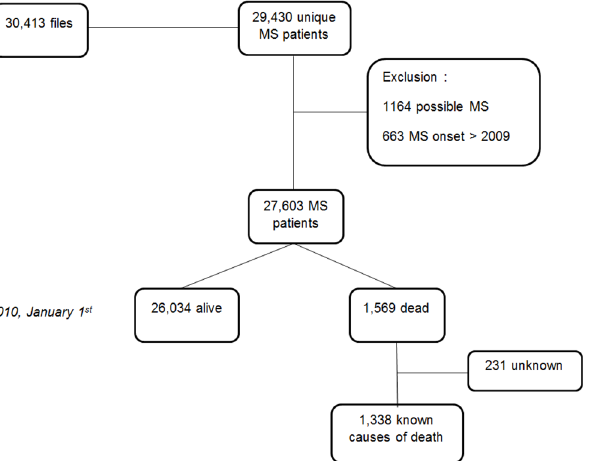
Fig 1. Flowchart of the study population. These patients had the classic characteristics of MS populations: F/M sex ratio 2.47 (19,656/7,947); mean age at MS clinical onset 32.8 ± 10.6 years; and 85.5% relapsing- onset MS (23,438/27,408; 195 missing values). As expected, mean age at onset was significantly higher and F/M sex ratio lower for progressive onset MS than for relapsing-onset MS (41.8 ± 10.8 vs. 31.2 ± 9.7 years, t test, p < 10 − 4 , and 1.40 vs. 2.76, Fisher ’ s exact test, p < 10 − 4 , respectively). MS = Multiple Sclerosis. doi:10.1371/journal.pone.0132033.g001 90.2] and 72.3% [70.4-74.1] of MS patients were still alive 25 and 40 years after clinical onset respectively.